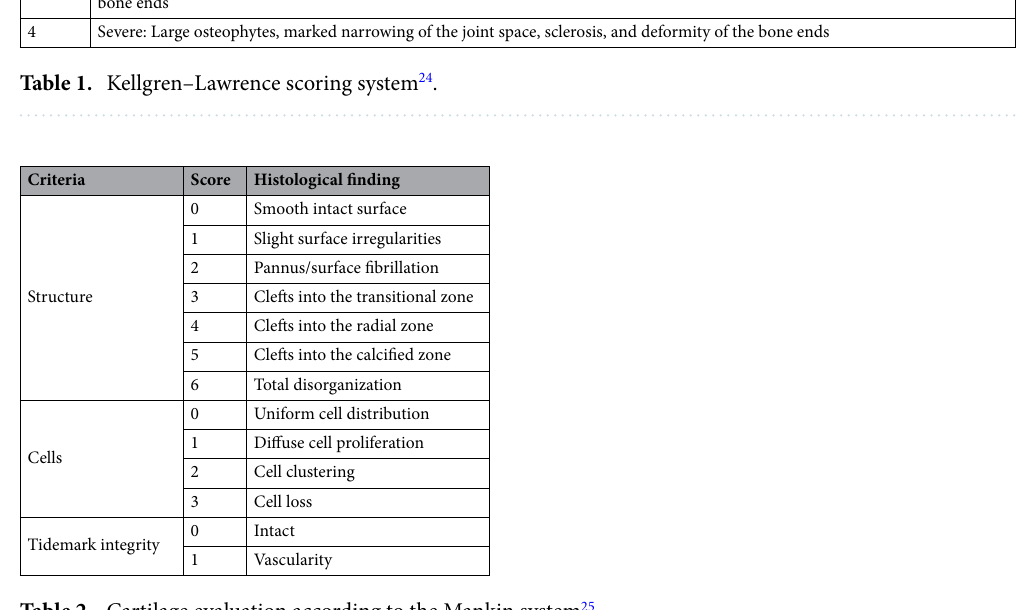
Table 2. Cartilage evaluation according to the Mankin system 25